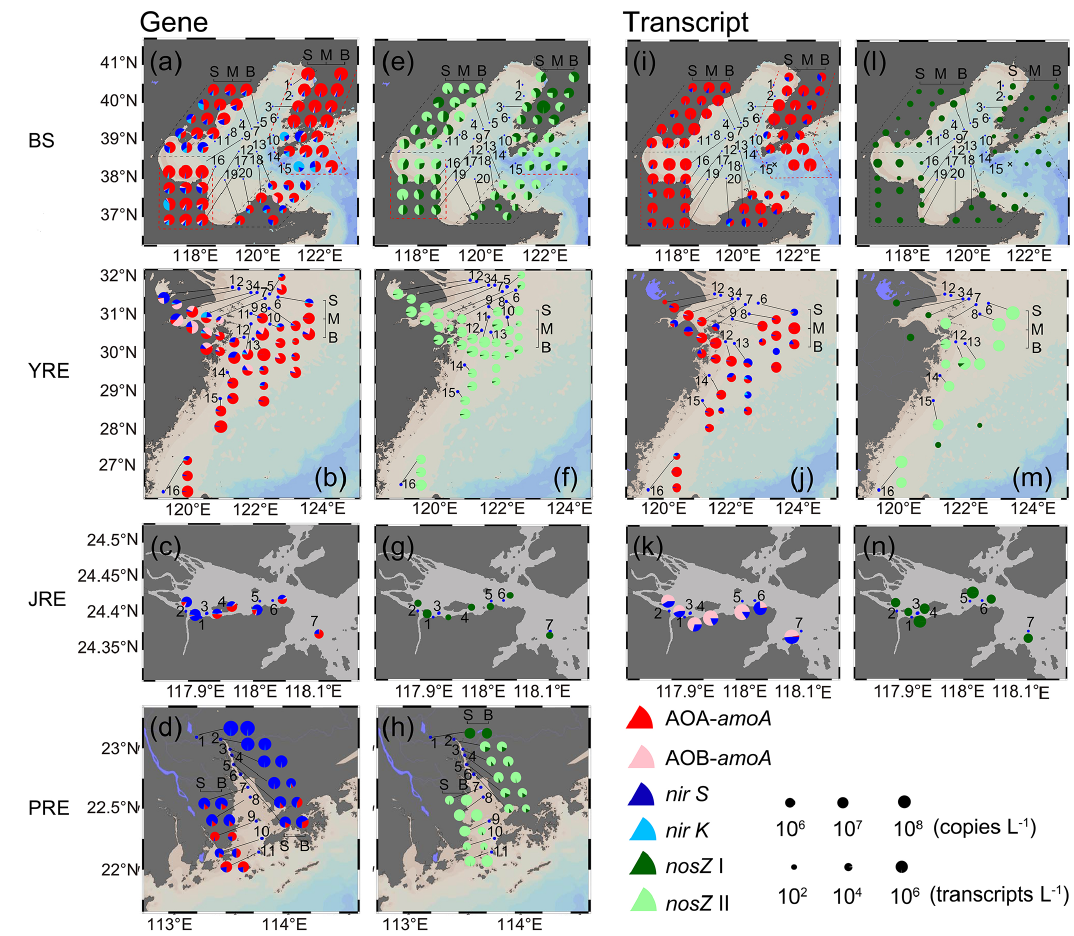
Figure 3. Six key functional gene and transcript abundance distributions in the Bohai Sea (BS), Yangtze River estuary (YRE), Jiulong River estuary (JRE), and Pearl River estuary (PRE). S: surface layer; M: middle layer; B: bottom layer. (a–d) Gene related to N 2 O production; (e–h) gene related to N 2 O consumption; (i–k) transcript related to N 2 O production; (l–n) transcript related to N 2 O